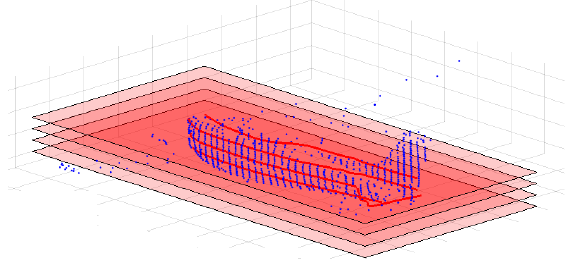
Figure 4. Aircraft point cloud (blue), the intersection planes (light red), and reference body curves marked by red lines